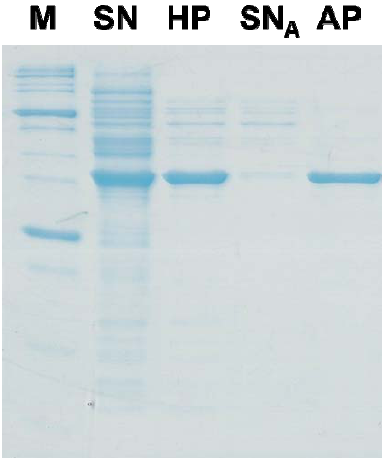
Figure 6. Simple purification of a thermoenzyme— Thermotoga maritima fructose-1,6-bisphosphate aldolase by heat precipitation and ammonia precipitation. M, protein marker; SN, supernatant of the cell lysate; HP, the supernatant after heat precipitation; SN , the precipitate after heat treatment containing the E. coli heat-labile A cellular proteins; AP, precipitated aldolase by using ammonia sulfate.